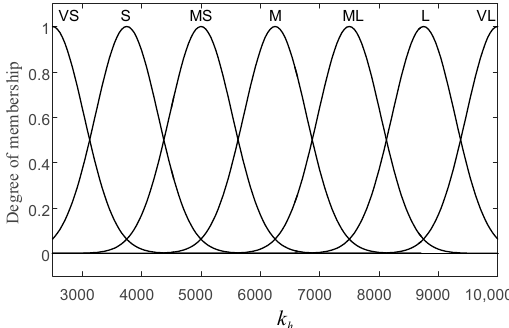
Figure 11. The upper limit of the change rate of the hydraulic braking torque membership function. According to the modified target hydraulic braking torque 𝑇 (cid:3035)_(cid:3045)(cid:3032)(cid:3044)(cid:4593) , the hydraulic controller determines the duty ratio of high-speed on–off valve, and directly controls the inlet valve and outlet valve of wheel cylinder through PWM modulation, so as to make the tracking pressure of wheel cylinders follow the modified target pressure changes.